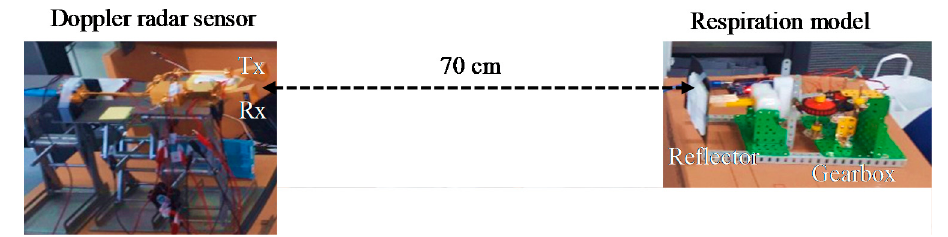
Figure 7. Respiration model experiment setup.